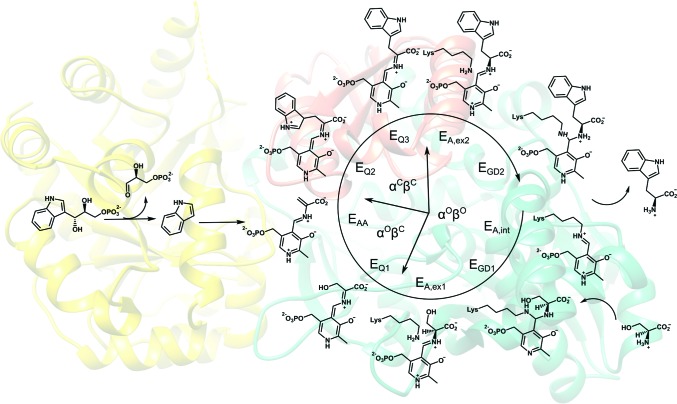
Enzymatic reaction of TrpAB. For TrpB, intermediate steps are shown (EA,int, internal aldimine; EGD1, geminal diamine; EA,ex1, external aldimine; EQ1, quinonoid; EAA, aminoacrylate; EQ2, quinonoid; EA,ex2, external aldimine; EGD2, geminal diamine).